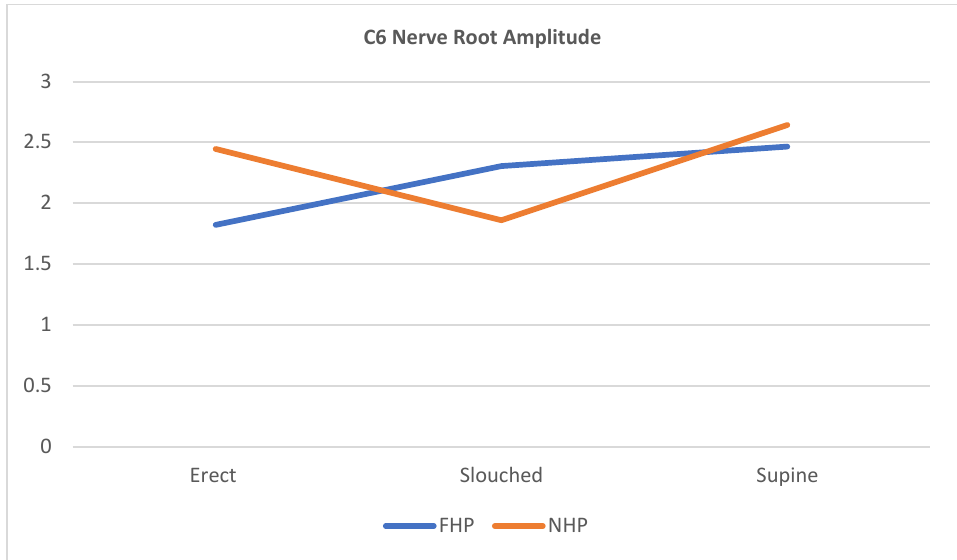
Figure 6. Short latency somatosensory-evoked potential of normal head posture (NHP) participant after prolonged slouched sitting for C6, C7, and C8. The amplitudes measured between N20 and P23 are: 2.81 μV, 2.81 μV, and 0.945 μV, respectively.